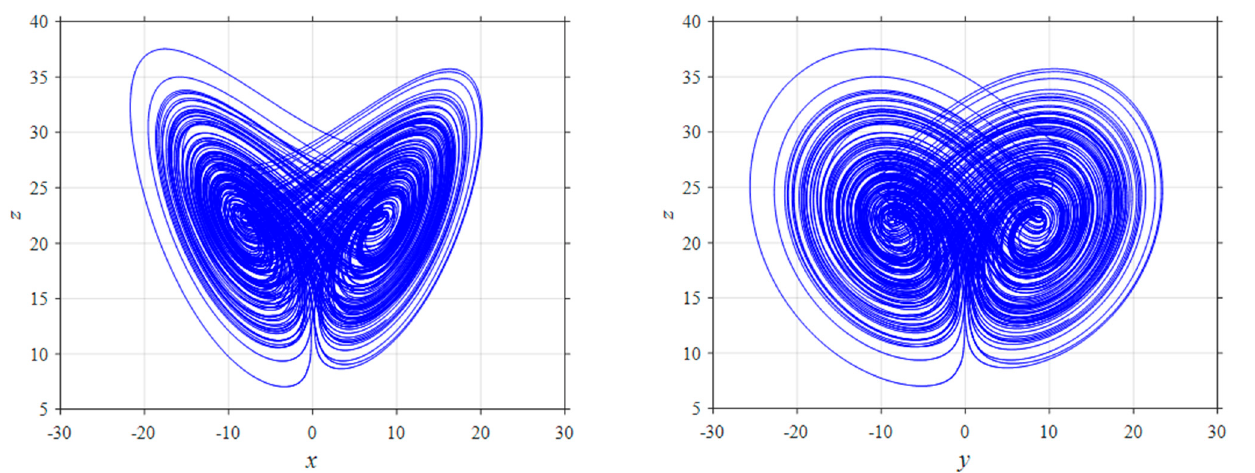
Figure 2. Fractional Chen system chaotic a tt ractor using SINC-DQM with time (cid:4666)𝑇 = 100(cid:4667) and frac- tion 𝜆 = 1.2,𝛾 = 0.85 , 𝑎 (cid:2869) = 35, 𝑎 (cid:2870) = 3, 𝑎 (cid:2871) = 28 , and 𝑥(cid:4666)0(cid:4667) = −9, 𝑦(cid:4666)0(cid:4667) = −5, 𝑧(cid:4666)0(cid:4667) = 14. 4.3. Problem 3 After substituting the Equations (25) and (26) in the fractional-order Lu system (6): ( ) (34c) The initial condition (7) is also addressed by substituting in the governing Equation (34). Also, Figure 3 shows the dynamic behaviors of a fractional Lu system with fraction order of 𝛾 = 0.93, 𝜆 = 1.2 at initial conditions 𝑥(cid:4666)0(cid:4667) = 0.2, 𝑦(cid:4666)0(cid:4667) = 0.5, 𝑧(cid:4666)0(cid:4667) = 0.3 and 𝑎 (cid:2869) = 36, 𝑎 (cid:2870) = 3, 𝑎 (cid:2871) = 20 .